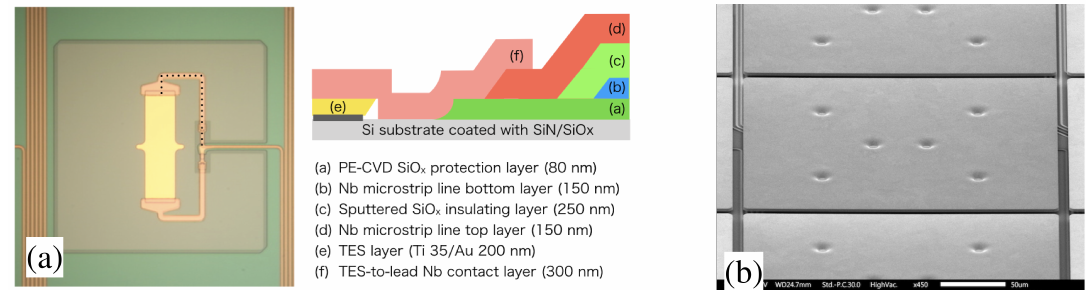
Figure 7. ( a ) Microphotograph of a 100 × 30 µ m 2 Ti/Au TES connected to the Nb superconducting leads and a schematic of a cutting view along with the dotted line. The separated leads are overlapped near the TES film but electrically separated with an oxide insulating layer, forming a microstripline. The figure was reprinted from [89] by permission from Springer Nature. Copyright ©2019, Springer Science Business Media. ( b ) Microphotograph of an Au X-ray absorber. The absorber is an overhanging structure supported by several stems that can be seen as dots on top of the absorber surface. The two of them located close to the center of the absorbers are thermally connected to the TES thermometer, not visible in the